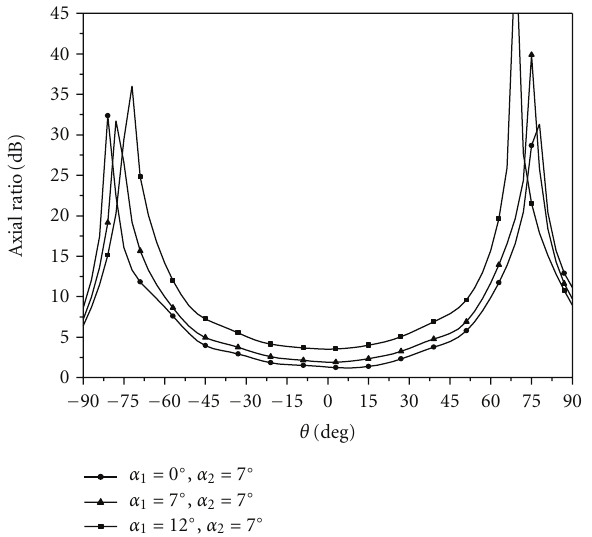
Figure 2: Wide angle axial ratio simulation results with variable pitch angle.